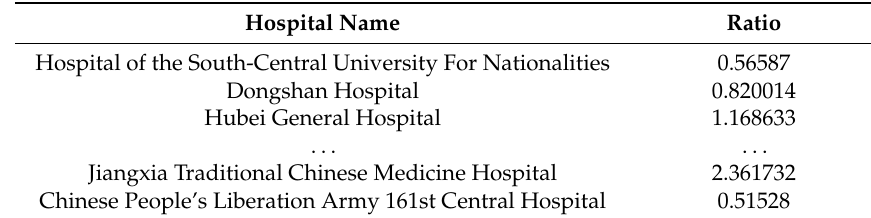
Table 6. Ratio of potential daily outpatients and actual daily average of outpatients for each hospital in Wuhan